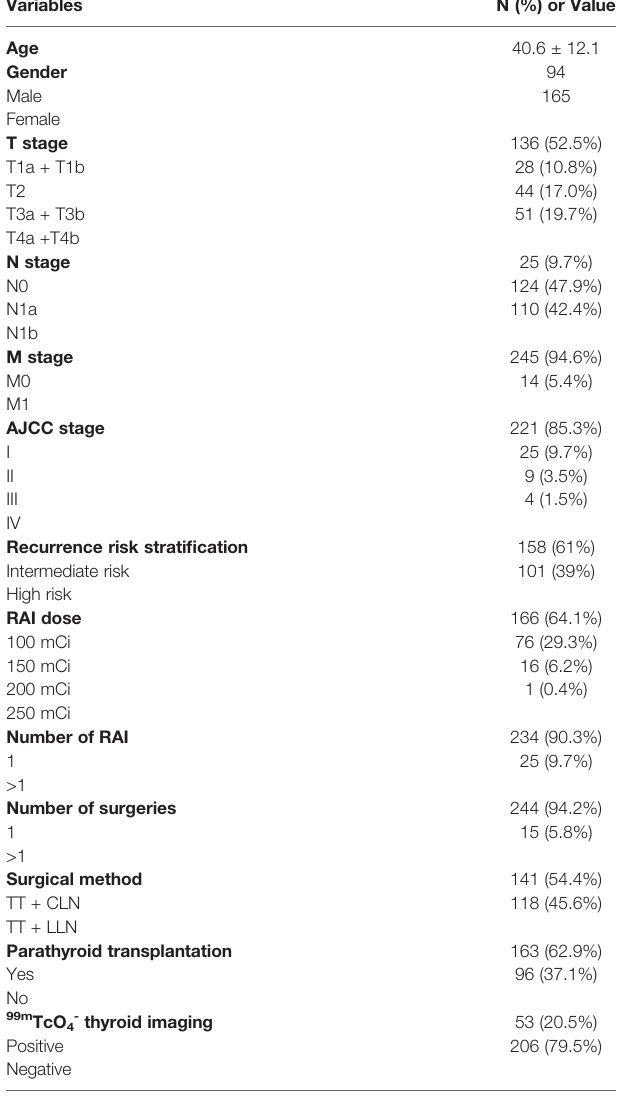
TABLE 1 | Clinical characteristics of the patients.